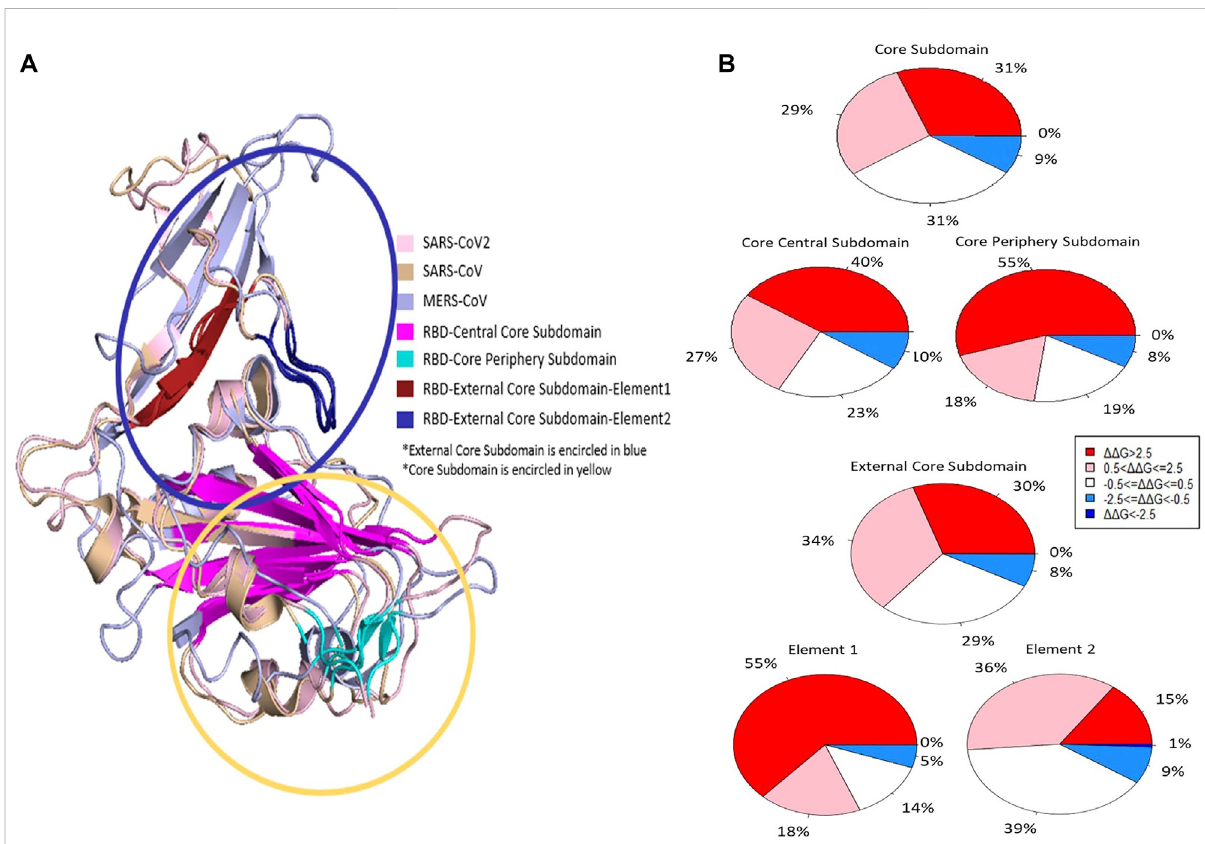
FIGURE 2 Structure of the RBD regions of SARS-CoV-2, SARS-CoV, and MERS-CoV S proteins (A) . The percentages of highly destabilizing, moderately destabilizing, neutral, and moderately stabilizing mutations found within the core and external core subdomains are depicted in (B)